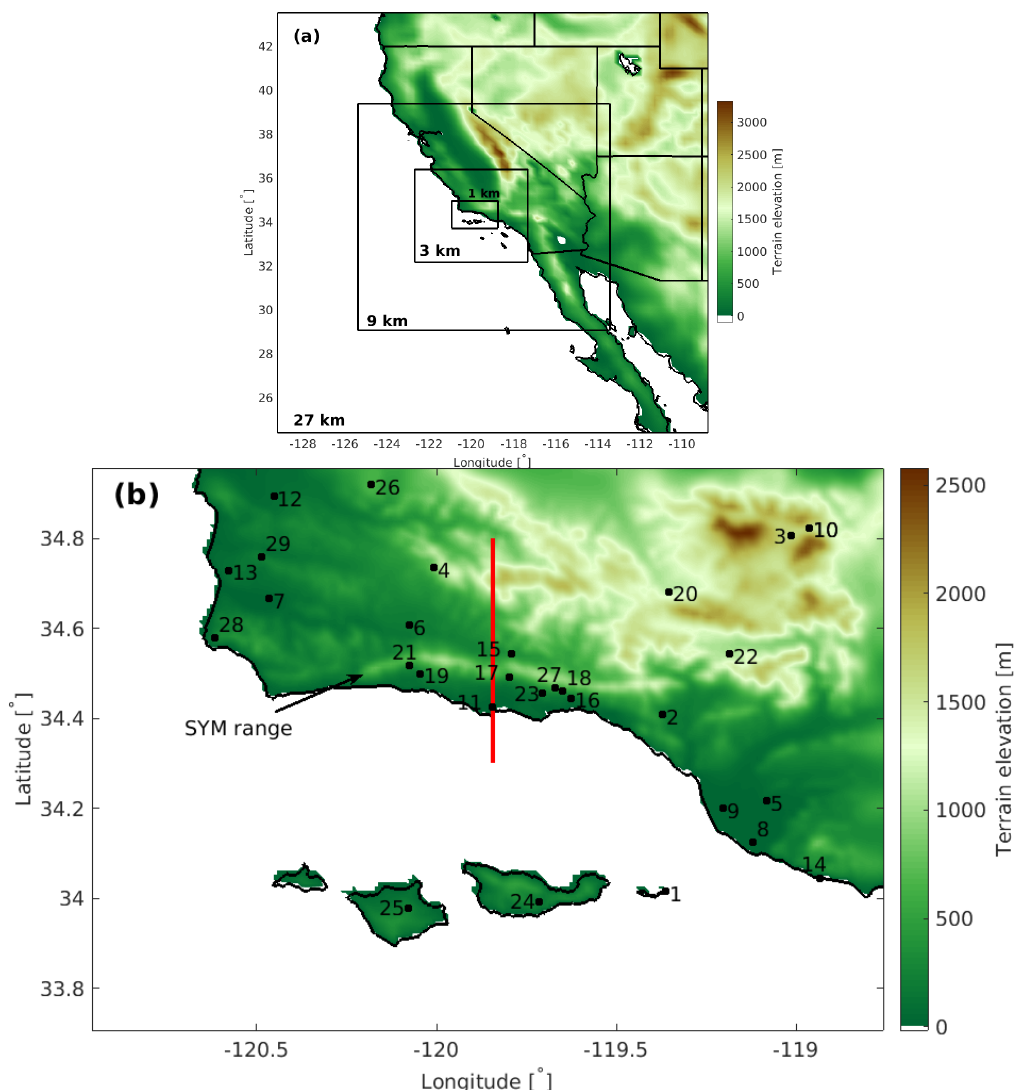
Figure 1. ( a ) Domain configuration for the WRF simulations, and ( b ) innermost domain and the available stations for model evaluation. Station locations are indicated by their number corresponding to Table S1. The red line indicates the location for the vertical cross sections used in Figures 7, 9 and